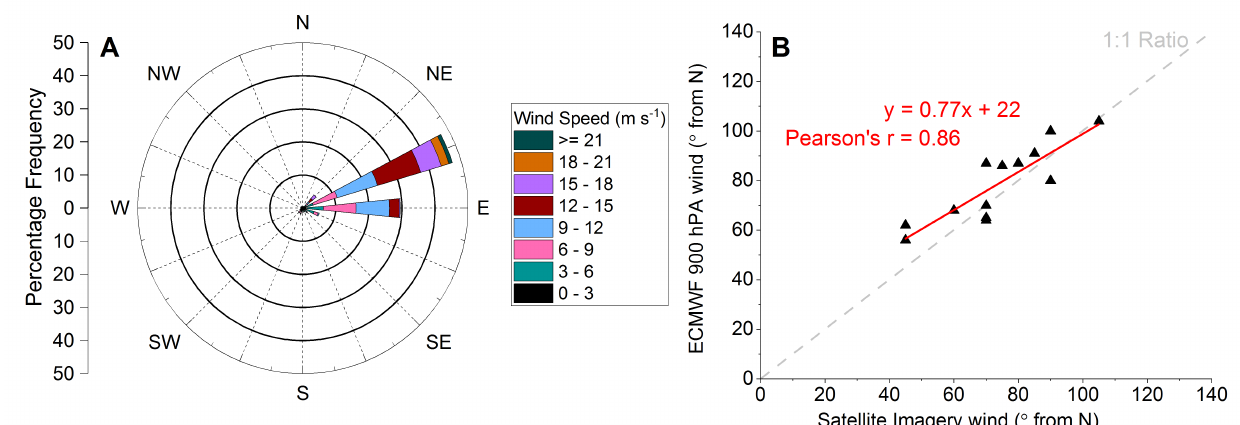
Figure 4: Forecast meteorological data for Masaya volcano. [A] Wind rose for the period February to August 2017 at 900 hPa, with an average geopotential height of 948 m ˘ 113 m. Wind direction is predominantly from the ENE and E. Data are derived from ECMWF forecast and are displayed as the direction the wind is blowing from. [B] Comparison between the ECMWF 900 hPA wind direction data and the wind directions derived from the satellite imagery over Masaya volcano.